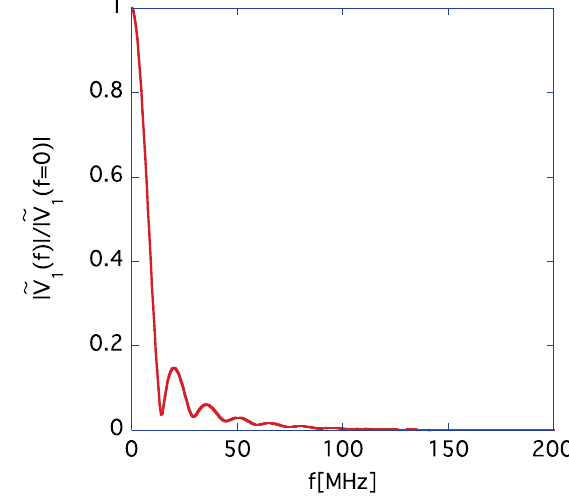
FIG. 12. Normalized Fourier transformed current pulse j ˜ V